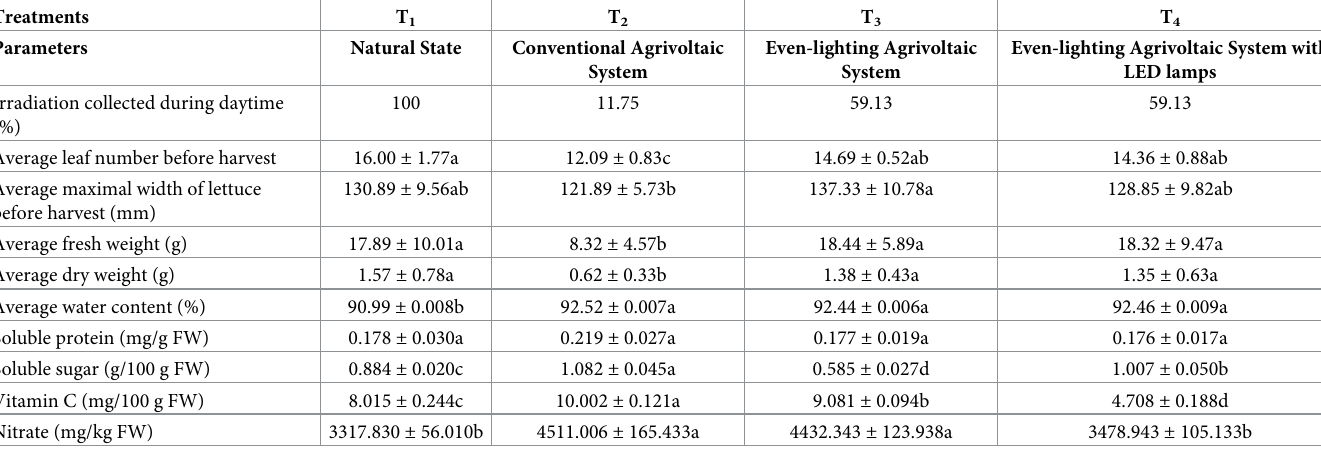
Table 4. Different light conditions and their effect on lettuce’s physiological parameters. Treatments